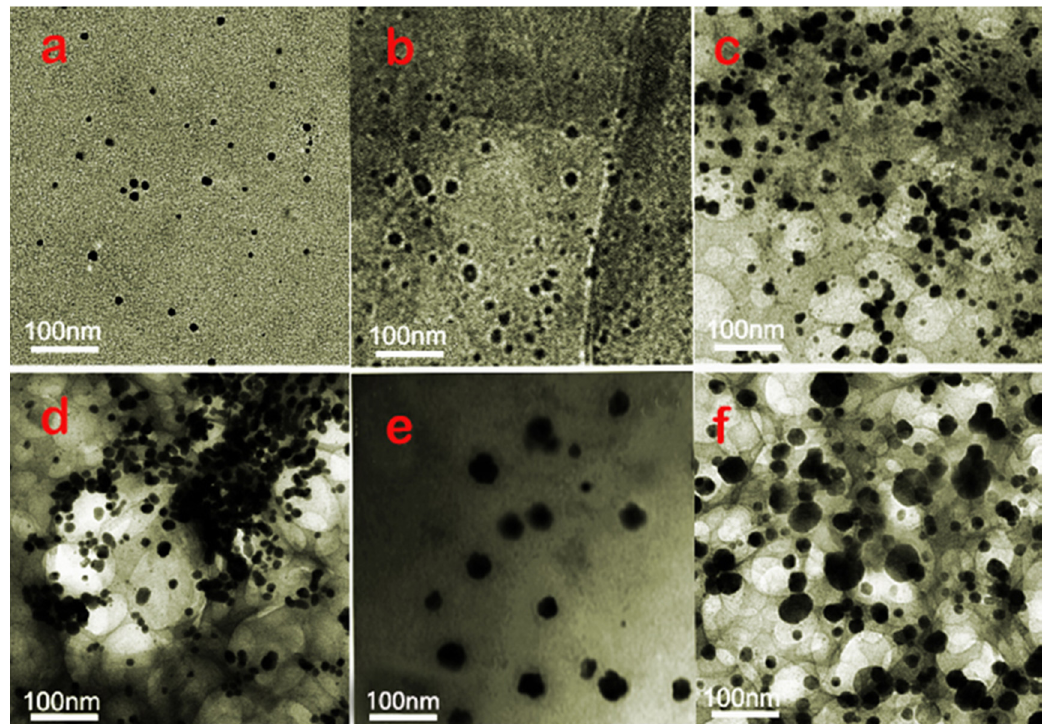
Figure 6. TEM images of WPU / NCC / AgNPs composites with 0.5% of NCC and different loadings of Ag: ( a ) 1%, ( b ) 3%, ( c ) 5%, ( d ) 5% without NCC, ( e ) 7%, ( f ) 10%.